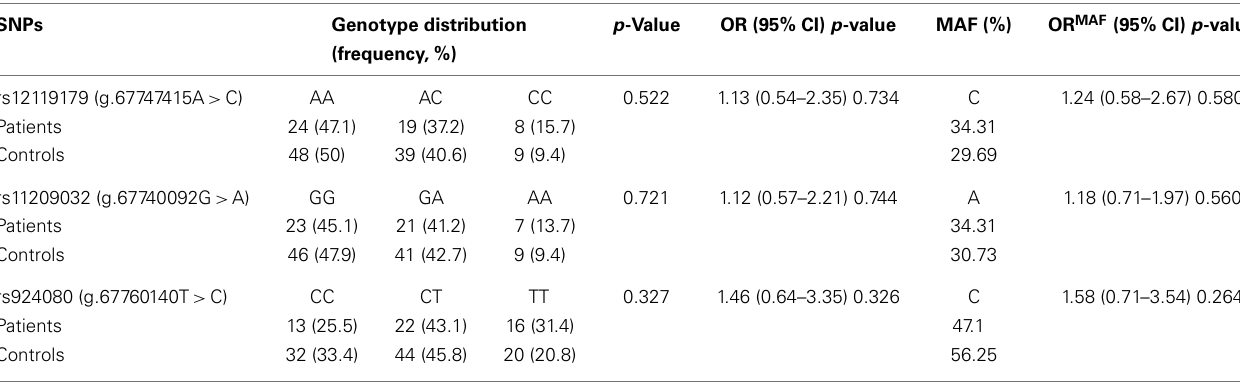
Table 6 |The distribution of IL23R - IL12RB2 genotypes in patients with Behçet